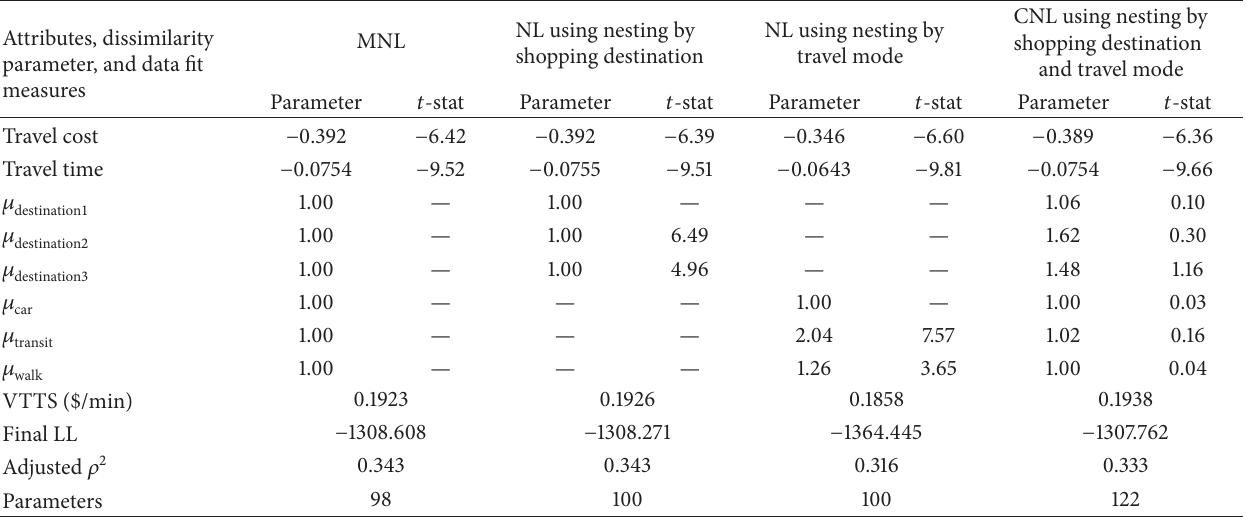
Table 4: Travel related parameter and data fit measures ( 𝑁 = 975